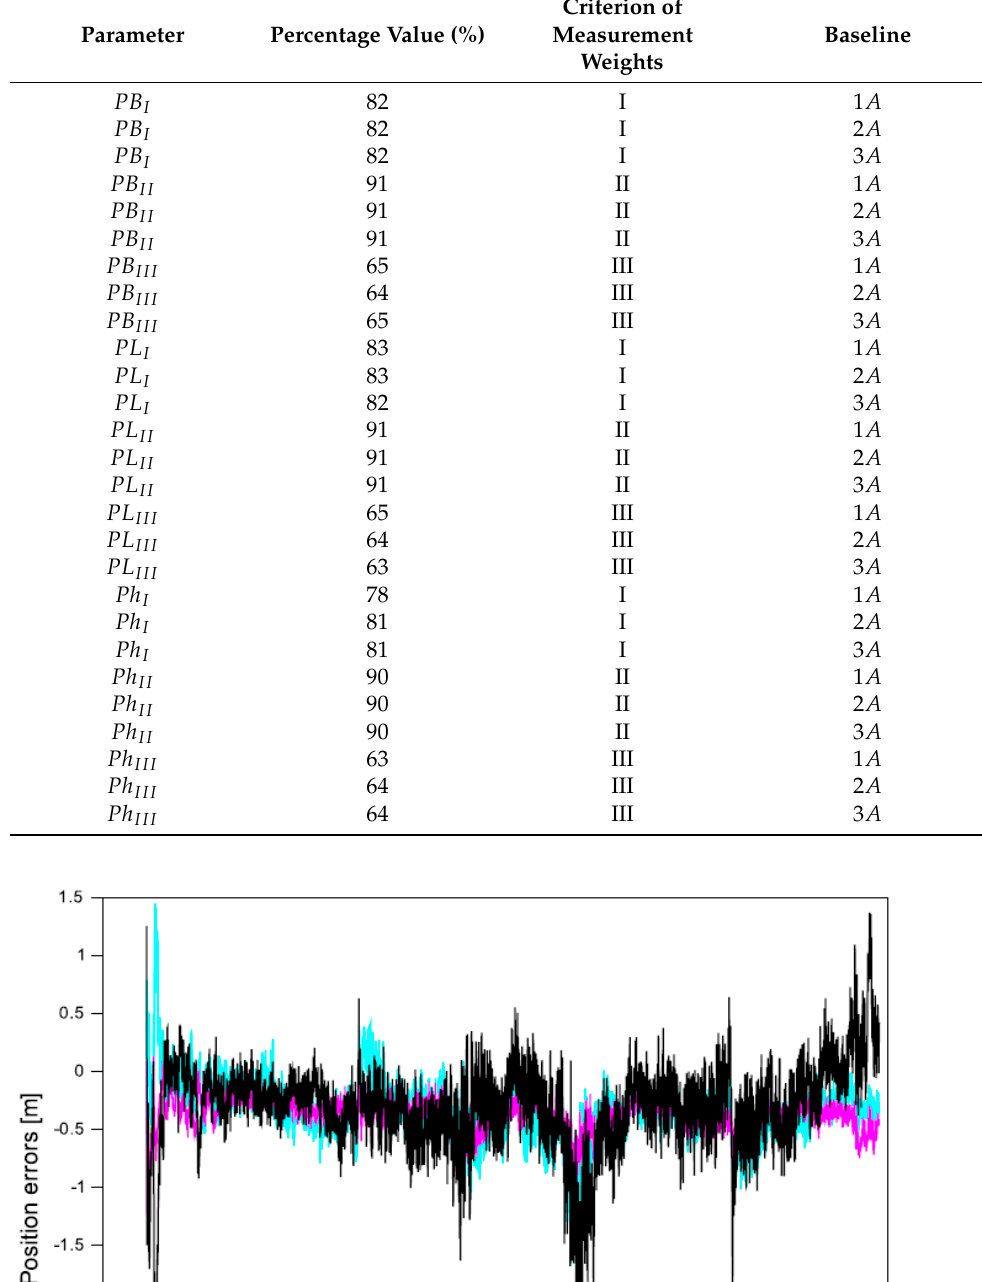
Table 5. The results of reducing the position errors in flight test in D˛eblin.